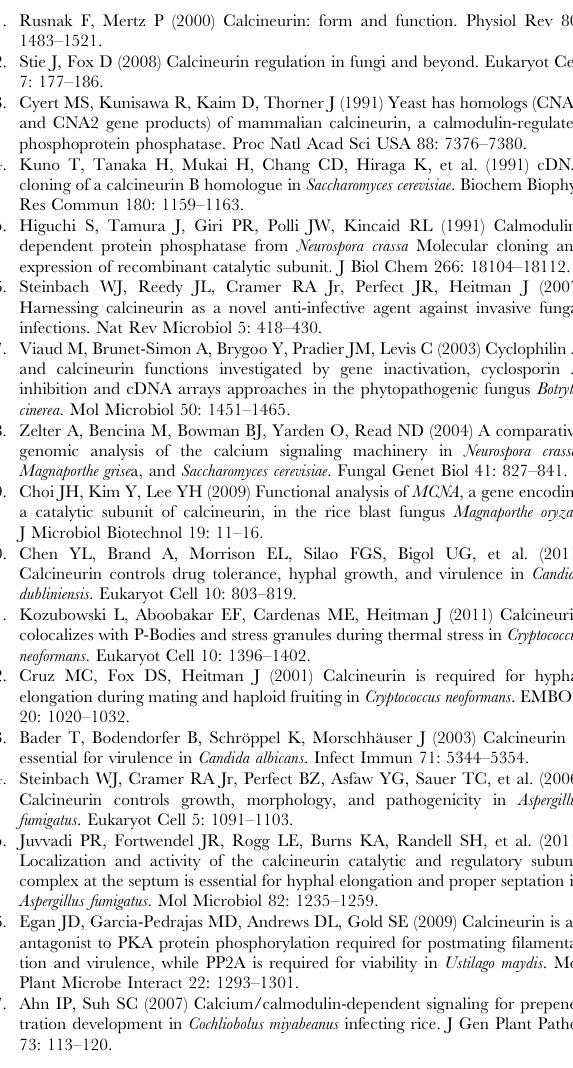
The first solid arrow line show Myristrylation site, the other solid arrow lines show the EF-hands motifs. Shaded regions indicate the same